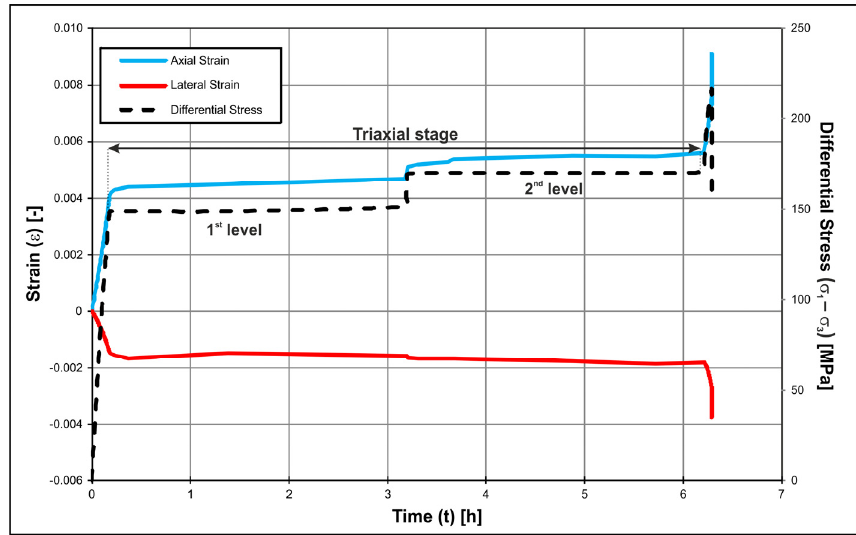
Figure 7. Characteristics of differential stress–axial, lateral and volumetric strain obtained from the brittle creep test for sample M-43-A.